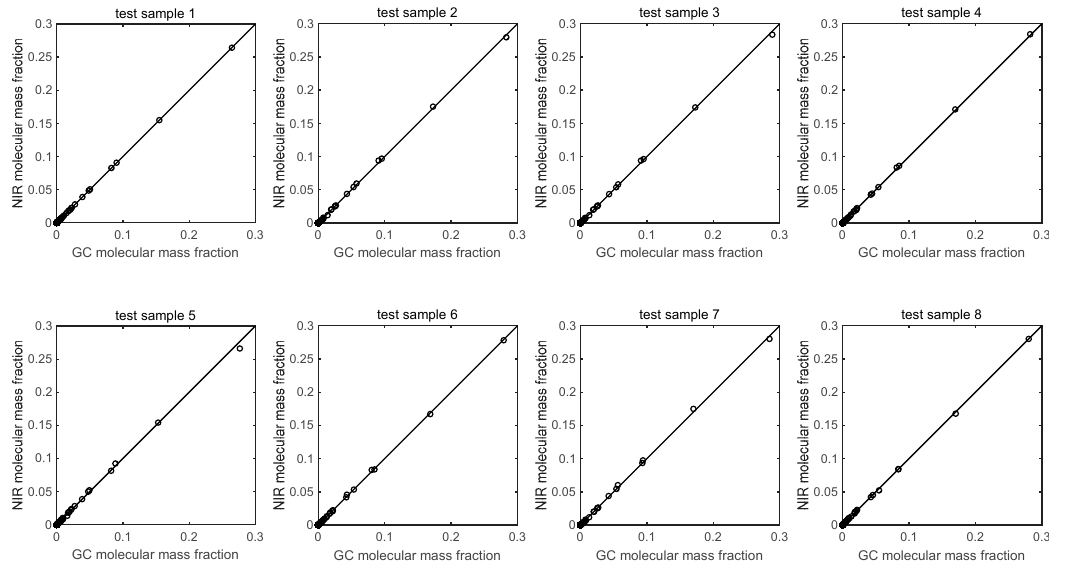
Figure 6. A comparison between predicted and measured molecular composition for different reformates. Table 3. Error analysis of molecular composition predicted from NIR spectroscopy for different reformates.